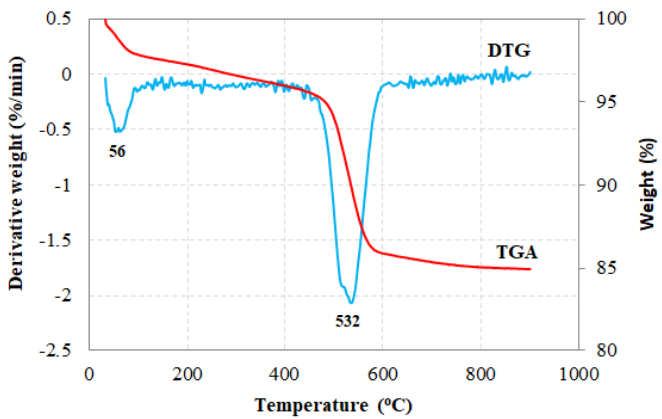
Figure 3. TGA and DTG curves of the bauxite ore.